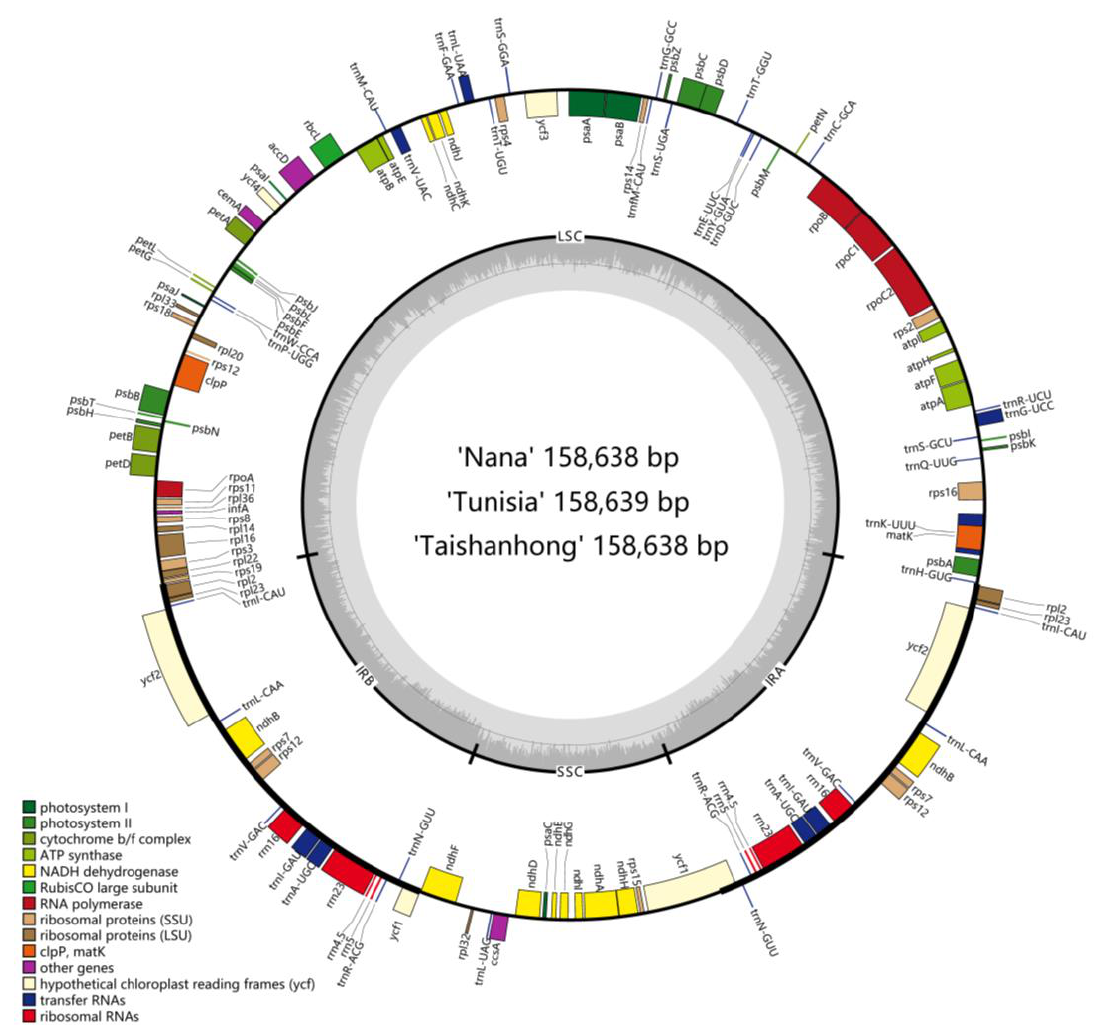
Figure 1. Chloroplast genome maps of P. granatum . Genes drawn outside the outer circle are transcribed clockwise, and those inside are transcribed counter-clockwise. Genes belonging to different functional groups are color-coded.